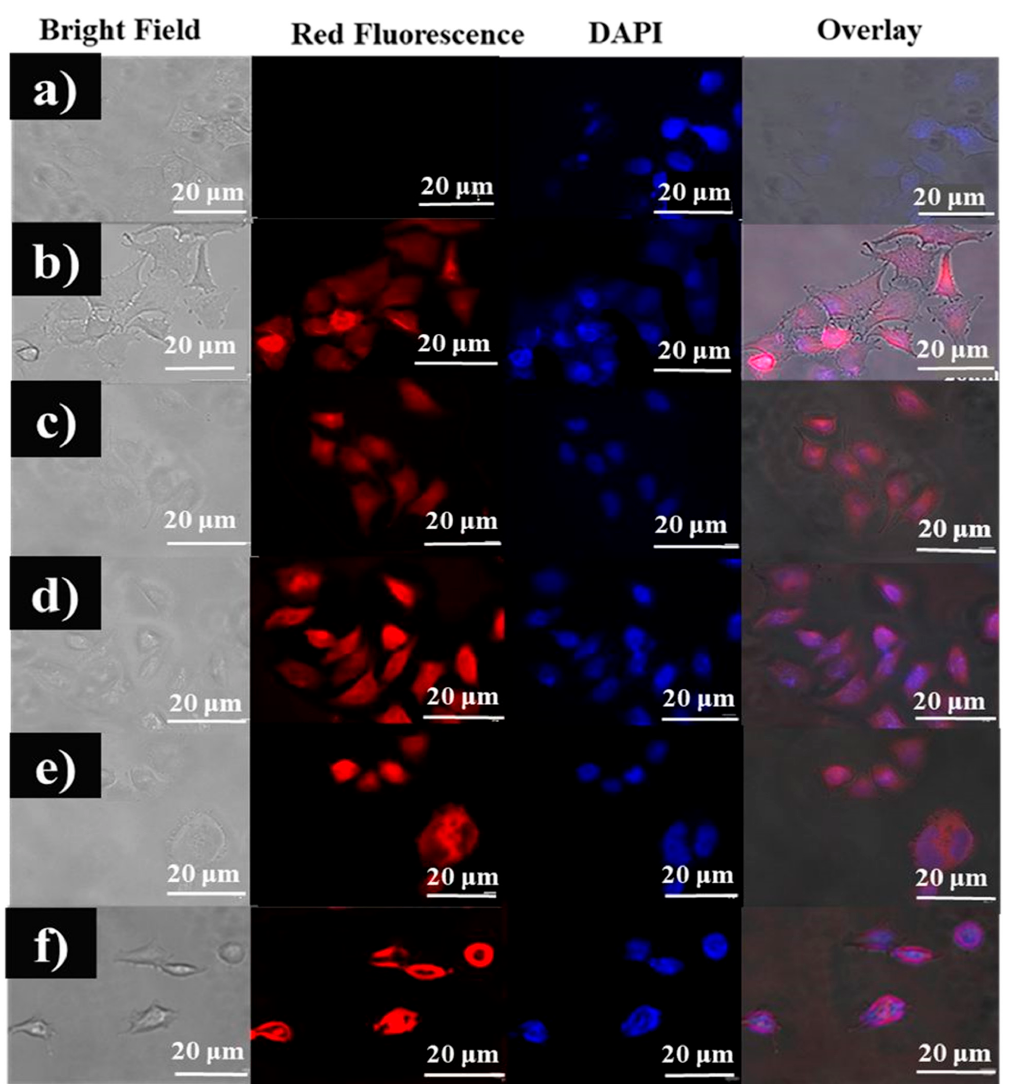
Figure 8. Cellular uptake of ( a ) control HeLa cells, ( b ) Cy3-treated HeLa cells, ( c ) Fuc-Cy3-treated HeLa cells, ( d ) Fuc-Cy3-L-Arg (1:1)-treated HeLa cells, ( e ) Fuc-Cy3-L-Arg (1:2.5)-treated HeLa cells, and ( f ) Fuc-Cy3-L-Arg (1:5)-treated HeLa cells. Table 2. Zeta potential charge measurement without and with the Cy3 dye complex. L-Argi- S. No. Oligo-fucoidan nine